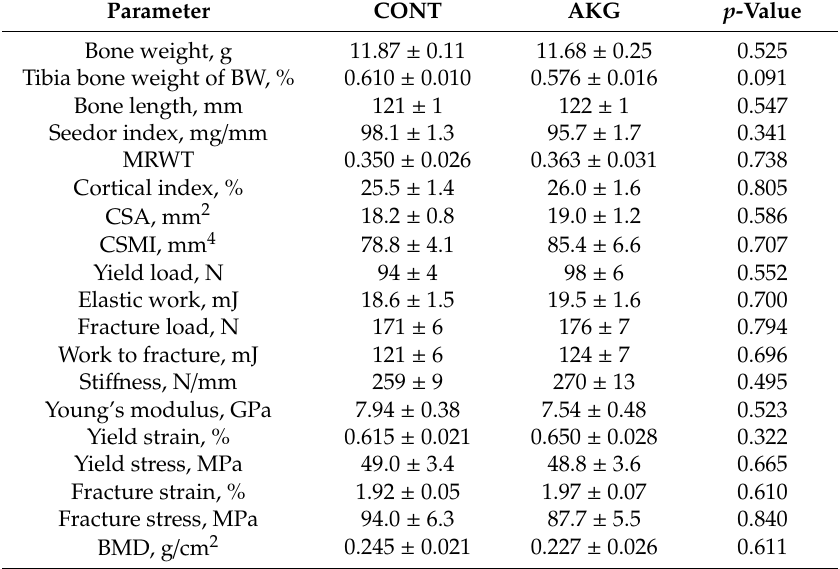
Table 6. The influence of AKG supplementation during the experimental period (31–60 weeks of age) on general, geometric and mechanical (structural and material) properties of tibia in laying hens at the age of 60